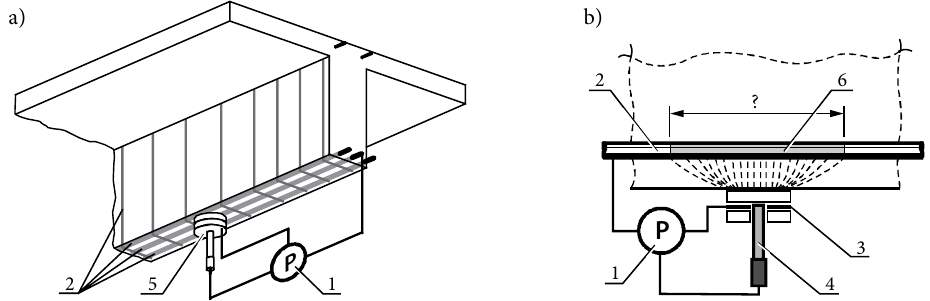
Fig. 1. The idea of impedance tests on the reinforcement of the reinforced concrete structures: a) view of the measuring system on a part of the reinforced concrete beam, b) the problem of identifying the polarization surface of long reinforcing bar in concrete